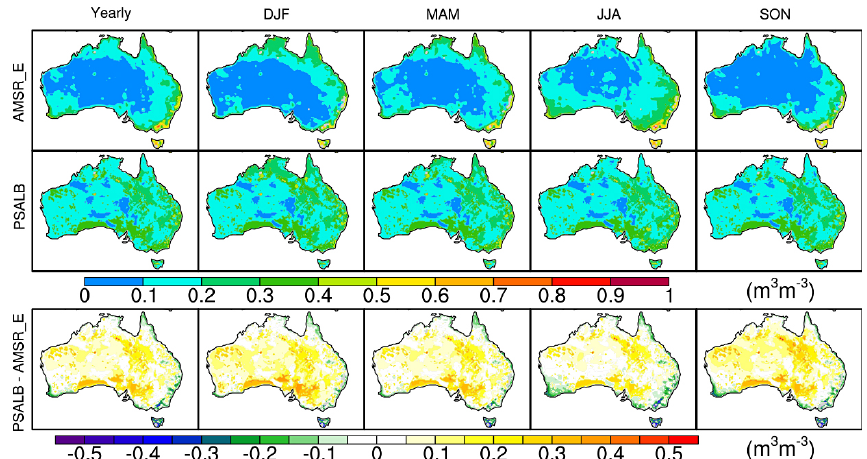
Figure 8. Yearly and seasonal soil moisture from AMSR–E and the PSALB experiment, and the difference between PSALB and AMSR–E (PSALB-AMSR_E).